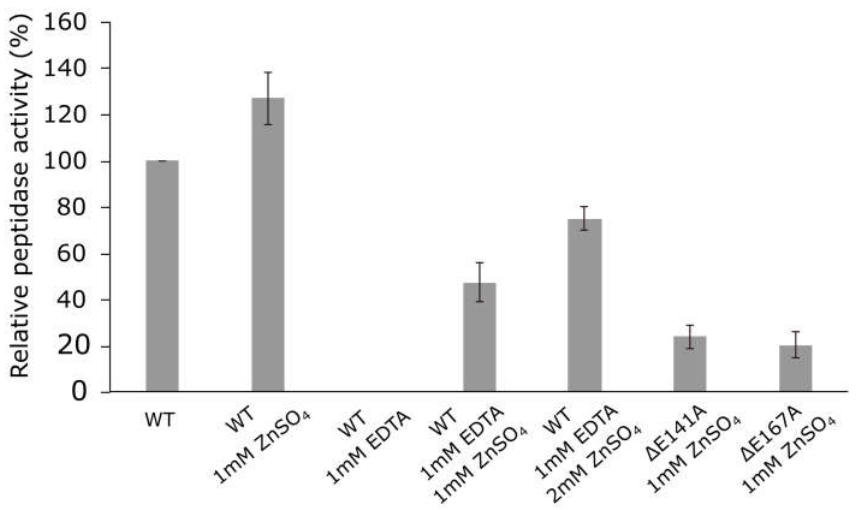
Figure 4. Peptidase activity of the wild-type Svx protein of Pectobacterium atrosepticum and its mutant forms SvxΔE141A and SvxΔE167A. The activities of the wild-type protein were measured in the absence (WT) or presence of 1 mM ZnSO 4 (WT 1 mM ZnSO 4 ) or 1 mM EDTA (WT 1 mM EDTA) or both 1 mM EDTA and either 1 mM or 2 mM ZnSO 4 (WT 1 mM EDTA (1 or 2) mM ZnSO 4 ). The activities of the mutant proteins were measured in the presence of 1 mM ZnSO 4 (ΔE141A 1 mM ZnSO 4 /ΔE167A 1 mM ZnSO 4 ). All reactions were carried out in 100 mM Tris-HCl buffer pH 7.5 at 40 °C.